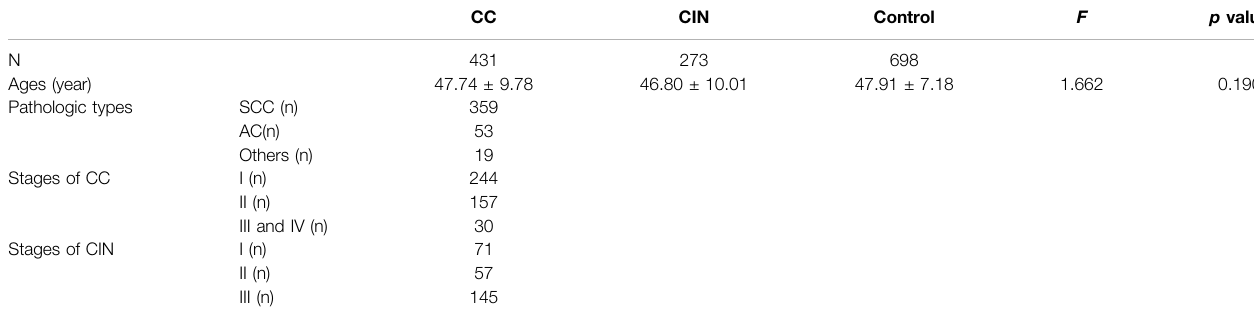
TABLE 2 | The clinical characteristics of the subjects enrolled in the current